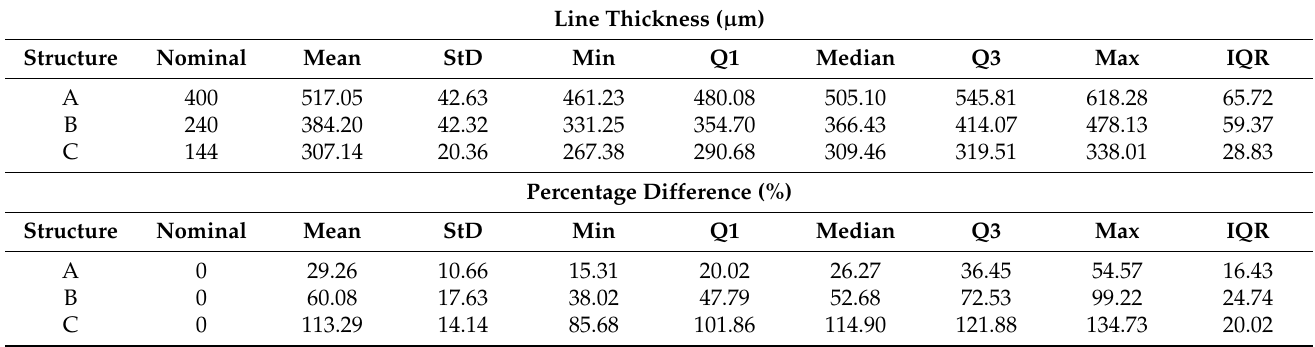
Figure 5. ( A ) Box plot of the line thickness of the first three structures of Figure 2. The lines indicate the nominal quotation. ( B ) Box plot of the percentage difference between the measured and the nominal thickness. The difference should be 0. All of the measures were higher than the nominal value, and more packed structures with a smaller line thickness had a higher percentage difference. Table 2. Descriptive statistic on both the measured line length of structures A, B, and C and their percentage difference with the nominal quotation. In all cases, the lines were thicker than the nominal value. In all cases, the measured thickness was higher than the nominal dimension. Interestingly, more packed structures with a smaller line thickness had a higher percentage difference. Line Thickness ( µ